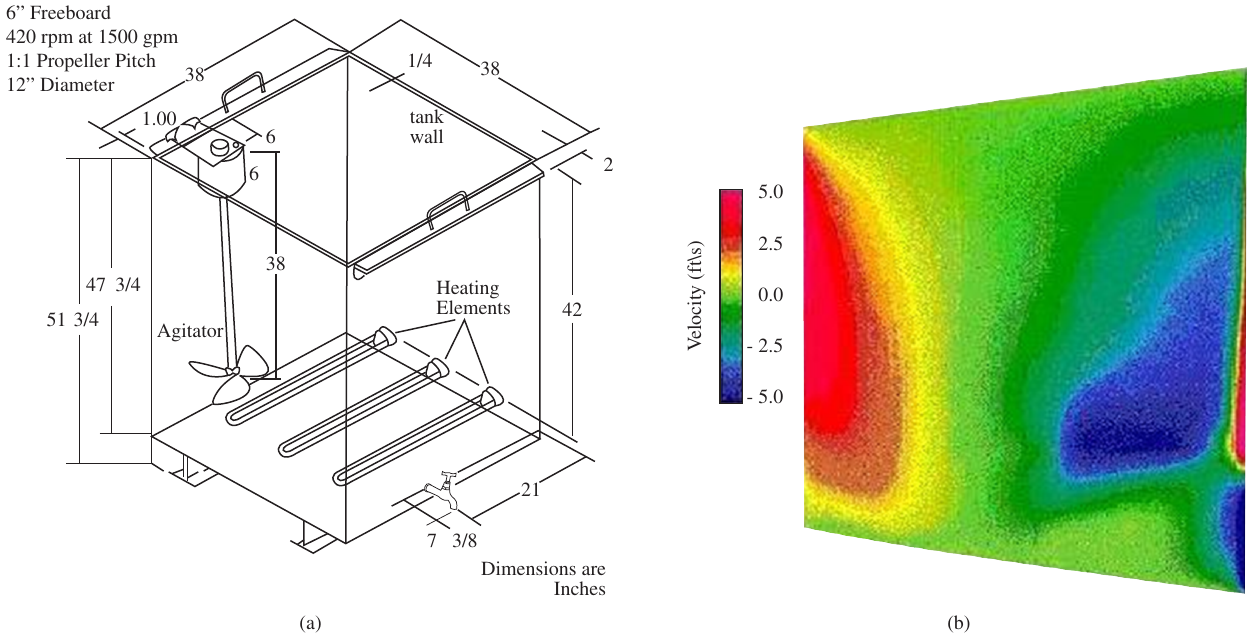
Figure 7. Flow velocity variation in a quench tank used for a SAE-AMEC quenchant